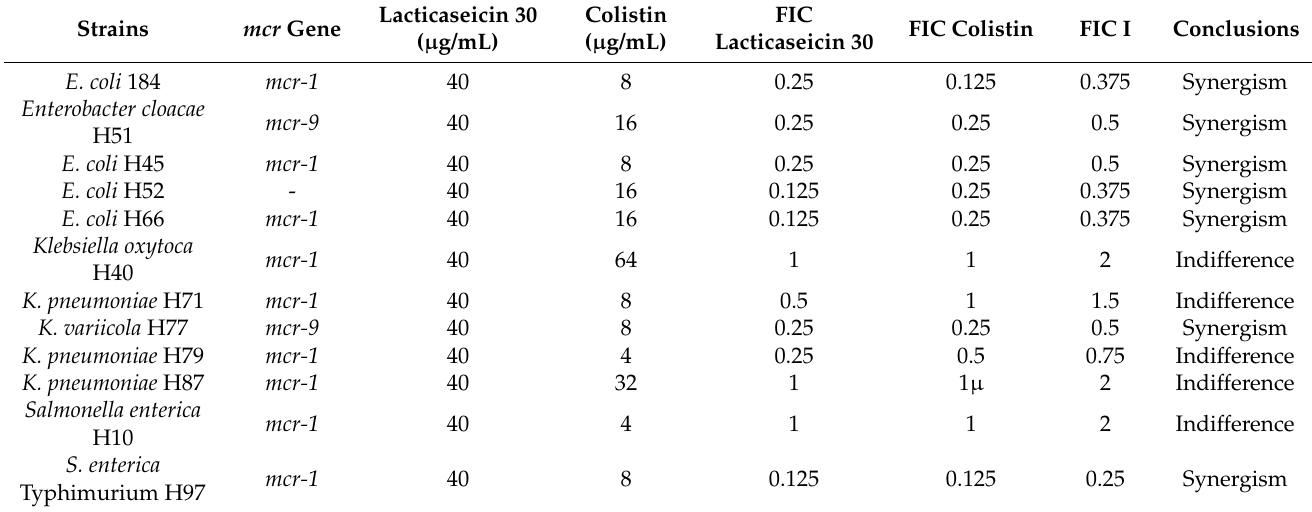
Table 2. Effects of the lacticaseicin 30-colistin combination against Gram-negative target bacteria displaying resistance to